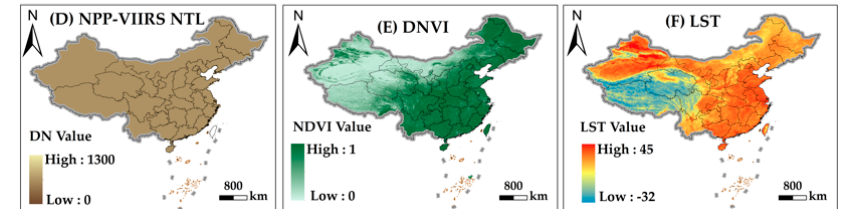
Figure 1. Study area: ( A ) The spatial distribution of 25 evaluation areas; ( B ) 1 km grid population data of China in 2015; ( C ) 1km grid gross domestic product (GDP) data of China in 2015; ( D ) The 2015 NPP-VIIRS NTL data of China; ( E ) The 2015 normalized difference vegetation index (NDVI) data of China; ( F ) The nighttime land surface temperature (LST) data of China in 2015. Table 1. The population (Pop) and GDP for Districts under City of the selected cities for 2015 (“Districts under City” includes all the city districts, not including counties and the city at lower levels).